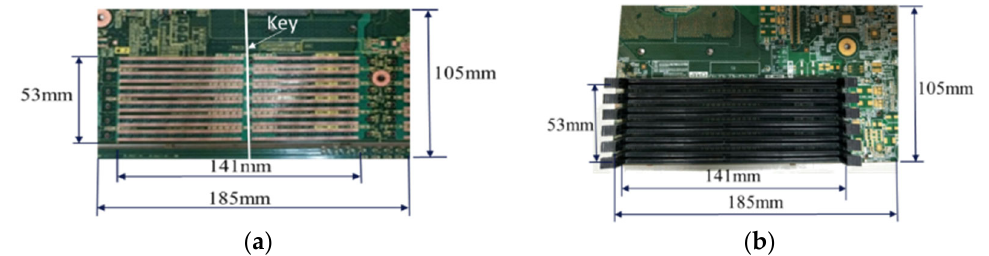
Figure 5. Con fi gurations of the test specimens: ( a ) the bare PCB and ( b ) a socket-PCB assembly with 6 sockets (a local assembly).